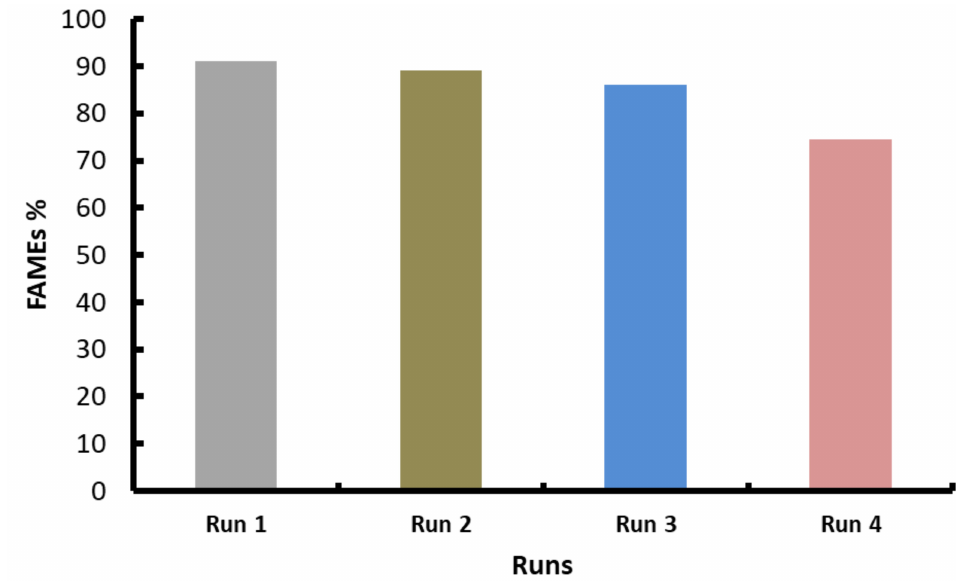
Figure 7. The reusability of Kocuria flava ASU5 immobilized lipase for biodiesel synthesis.